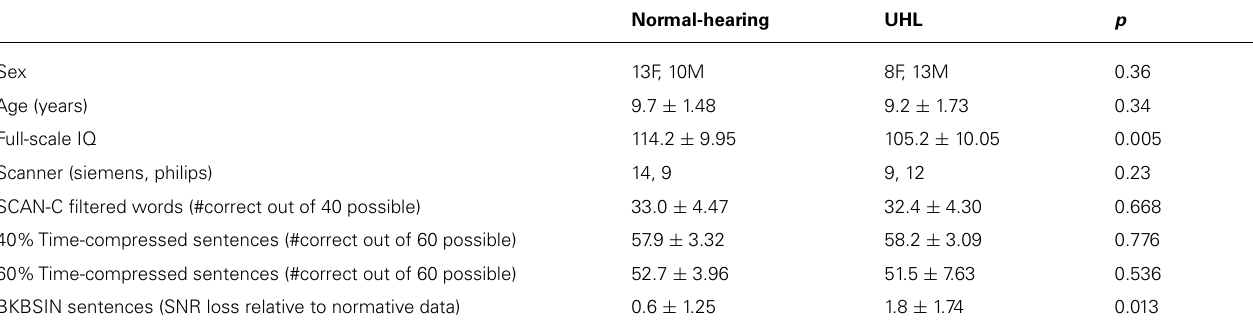
Table 2 | Demographic information,WISC-IV Full-Scale IQ, type of scanner used, and performance on four tests typically used to test for auditory processing disorder in children for the normal-hearing children in the study and the children with unilateral hearing loss (mean ± std).